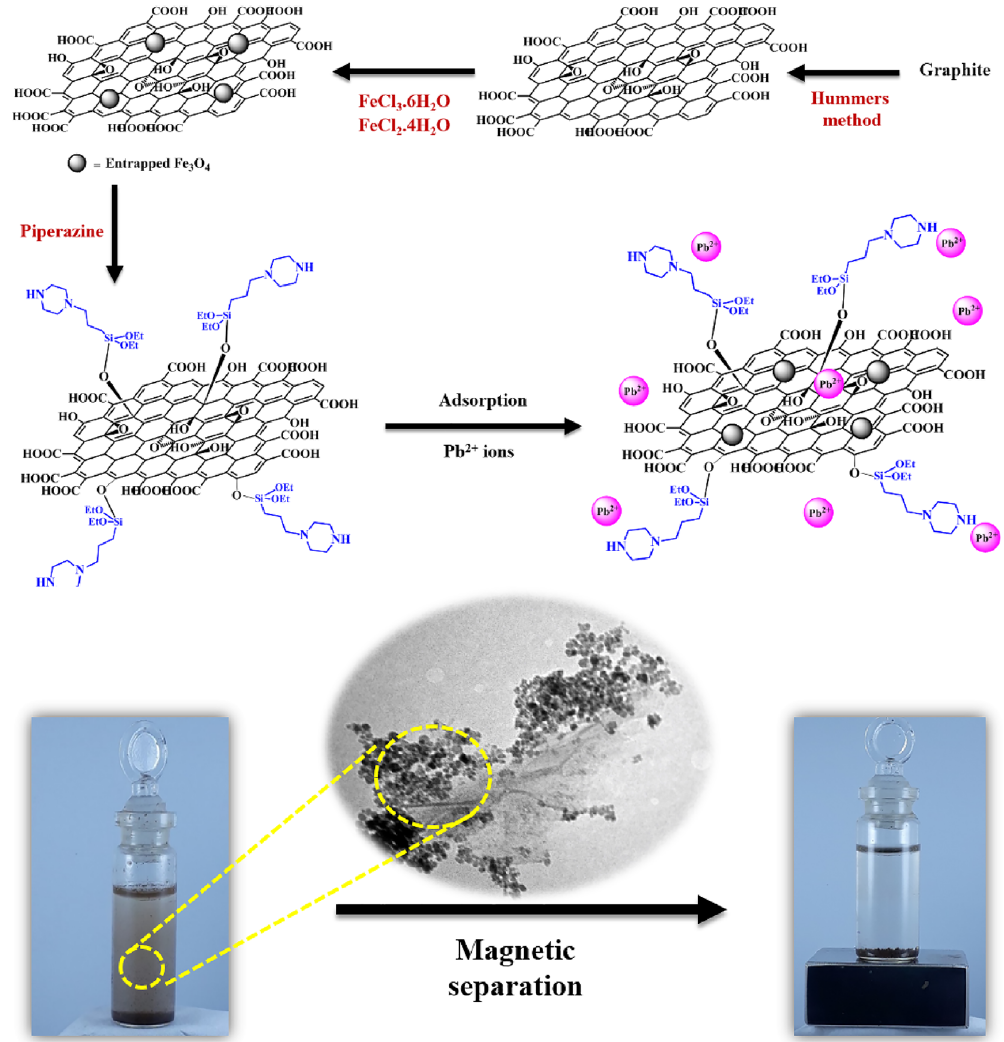
Figure 1. Schematic representation of synthesis of Pip@MGO nanocomposite and postulated mechanism for Pb 2+ ions adsorption.